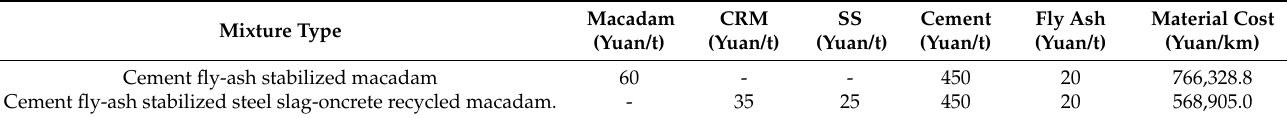
Table 6. Economic analysis of two